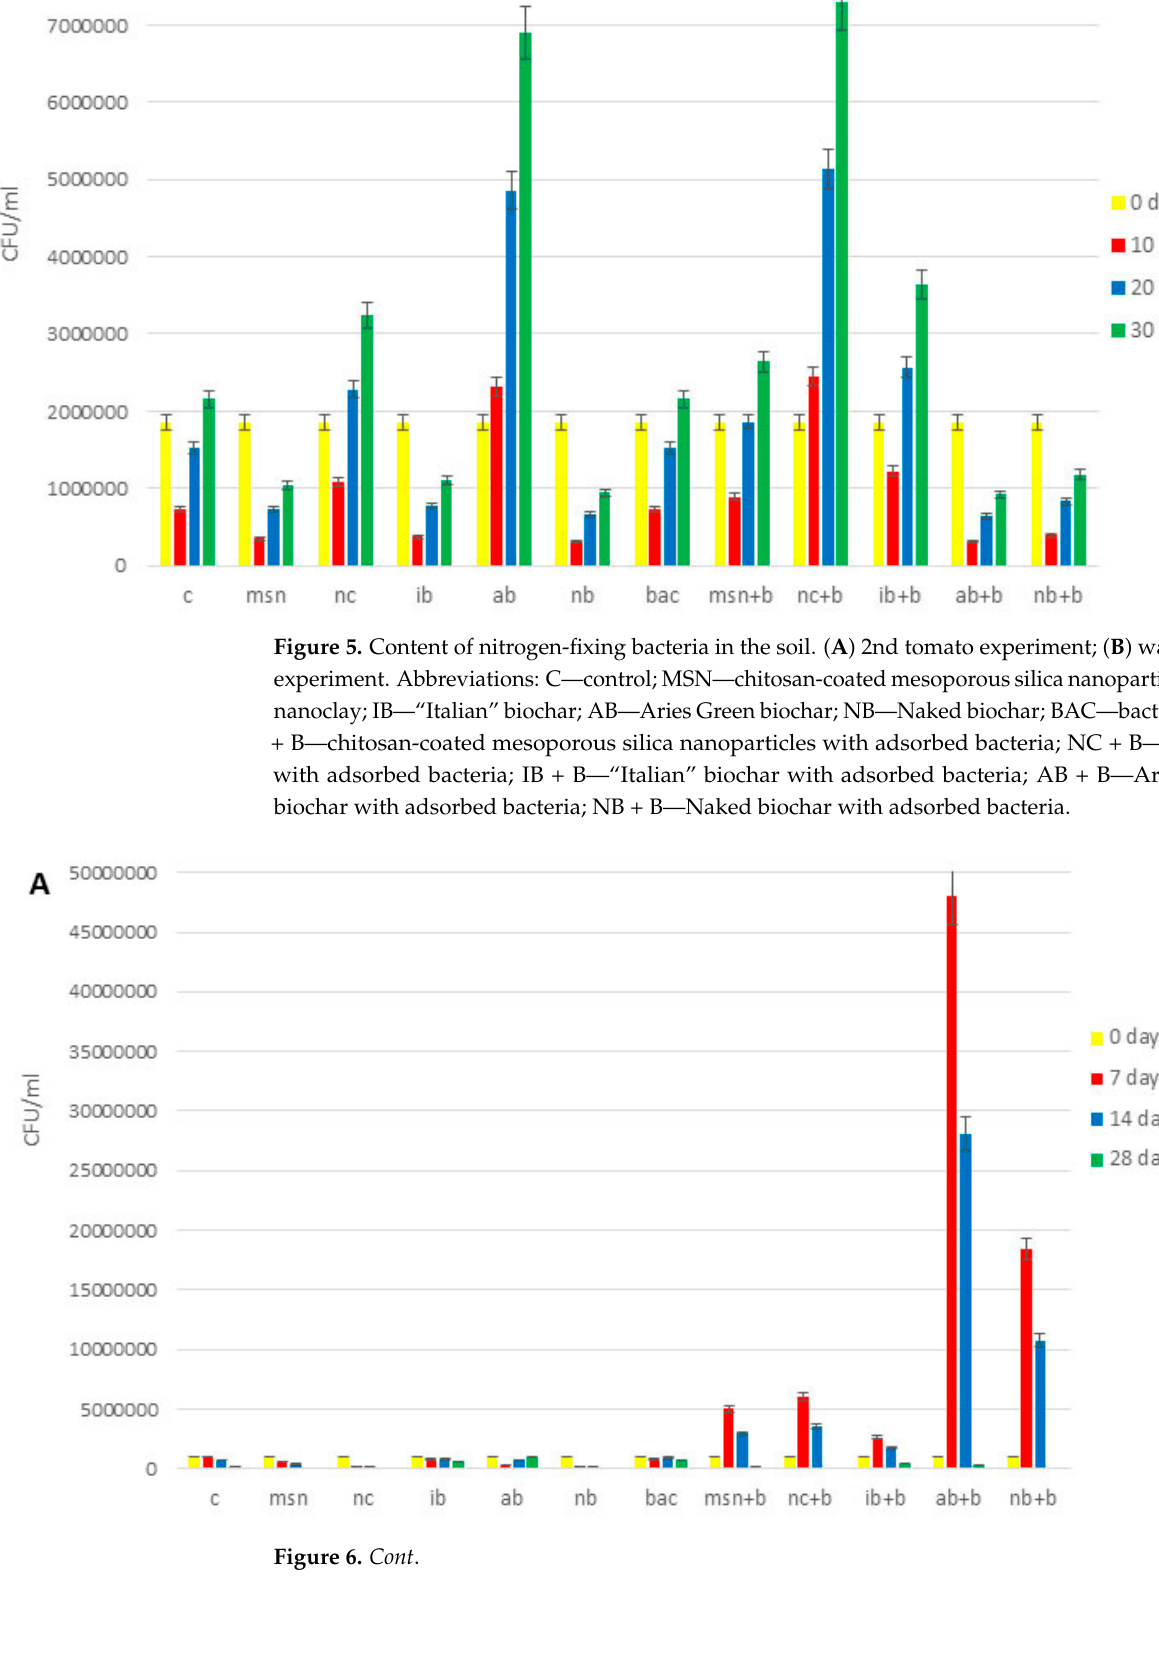
Figure 6. Content of phosphorus-solubilizing bacteria in the soil. ( A ) 2nd tomato experiment; ( B ) watermelon experiment. Abbreviations: C—control; MSN—chitosan-coated mesoporous silica na- noparticles; NC—nanoclay; IB—“Italian” biochar; AB—Aries Green biochar; NB—Naked biochar; BAC—bacteria; MSN + B—chitosan-coated mesoporous silica nanoparticles with adsorbed bacteria; NC + B—nanoclay with adsorbed bacteria; IB + B—“Italian” biochar with adsorbed bacteria; AB + B—Aries Green biochar with adsorbed bacteria; NB + B—Naked biochar with adsorbed bacteria. These results are in accordance with Husna et al. [16] and Hansen et al. [23], both of whom found that the addition of biochar increased the content of beneficial bacteria in soil, and also with Yang et al. [24], who demonstrated that the type of biochar strongly